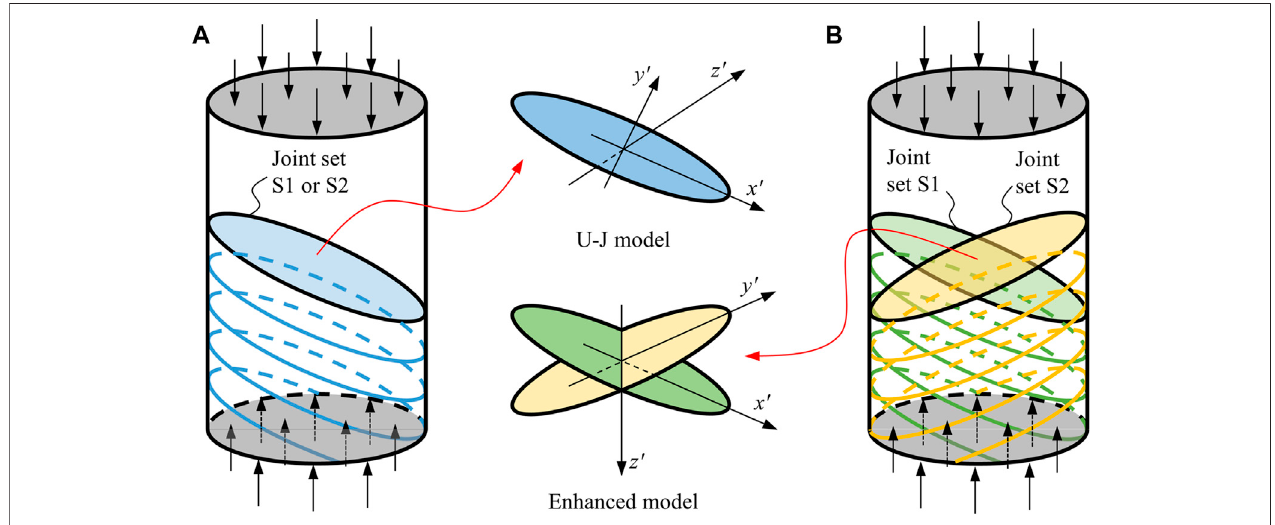
FIGURE 5 | Schematic diagram of difference in triaxial compression tests between the use of U-J model (A) and the enhanced model (B) .